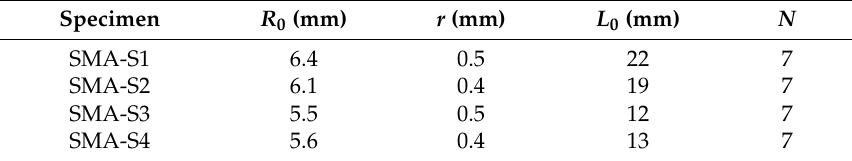
Figure 7. SMA helical spring specimens: ( a ) SMA-S1; ( b ) SMA-S2; ( a ) SMA-S3; ( b ) SMA-S4. Table 2. Geometrical parameters of the SMA helical spring specimens.